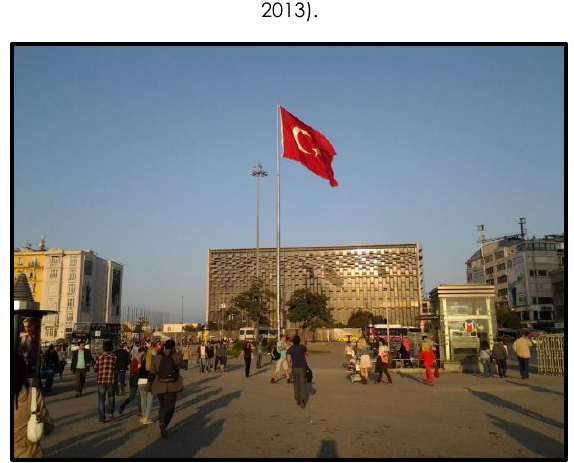
Figure 3. Taksim Republic Monument (authors' archive, May 2013).